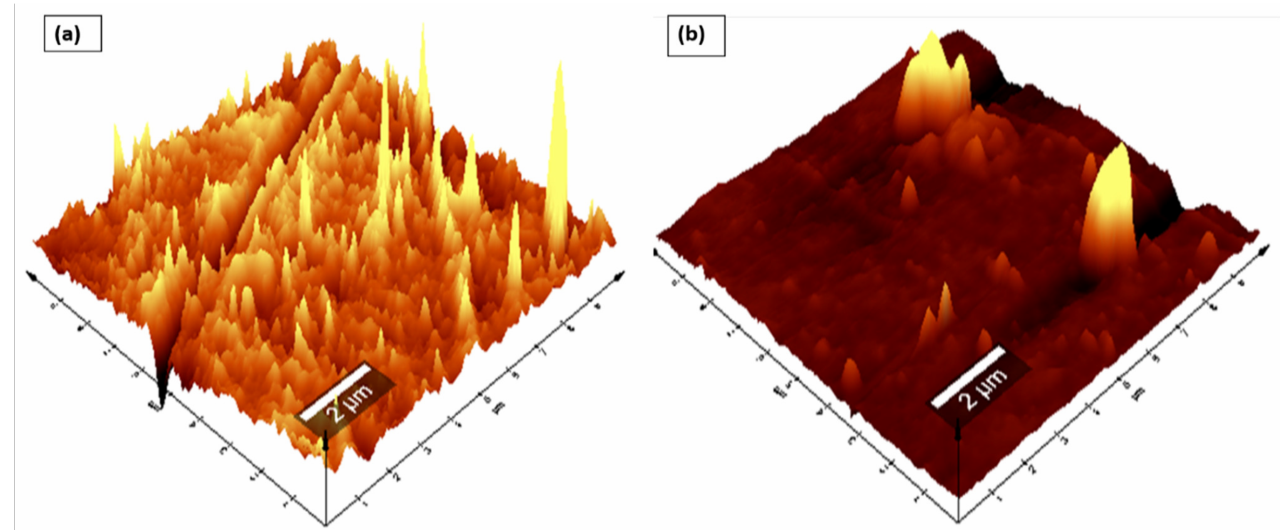
Figure 3. AFM ( a , b ) topography amplitude image of Nafion ® /S-ZrO 2 and Nafion ® /ZrP nanocom- posite membranes.